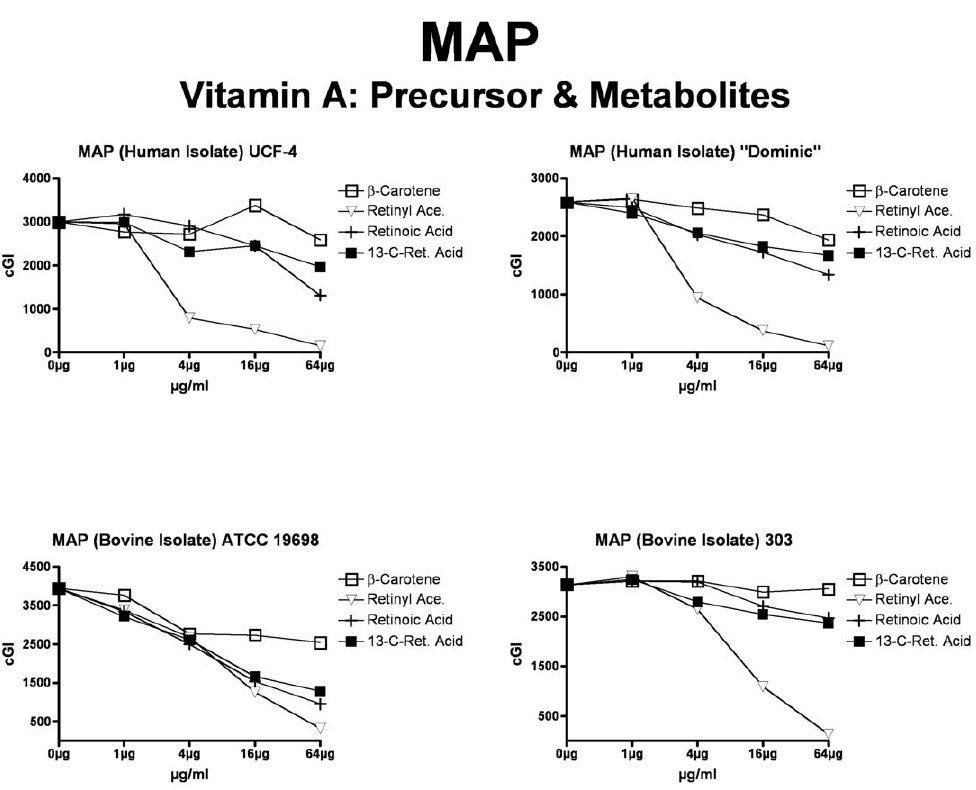
Figure 7. The effects of vitamin A precursors and metabolites on MAP. ß-carotene, the precursor to vitamin A, exhibits no inhibition at the doses studied. Maximal inhibitory activity against all MAP strains is observed with Retinyl acetate (solid black triangles.) Both Retinoic acid and 13-cis Retinoic acid exhibit intermediate inhibition.